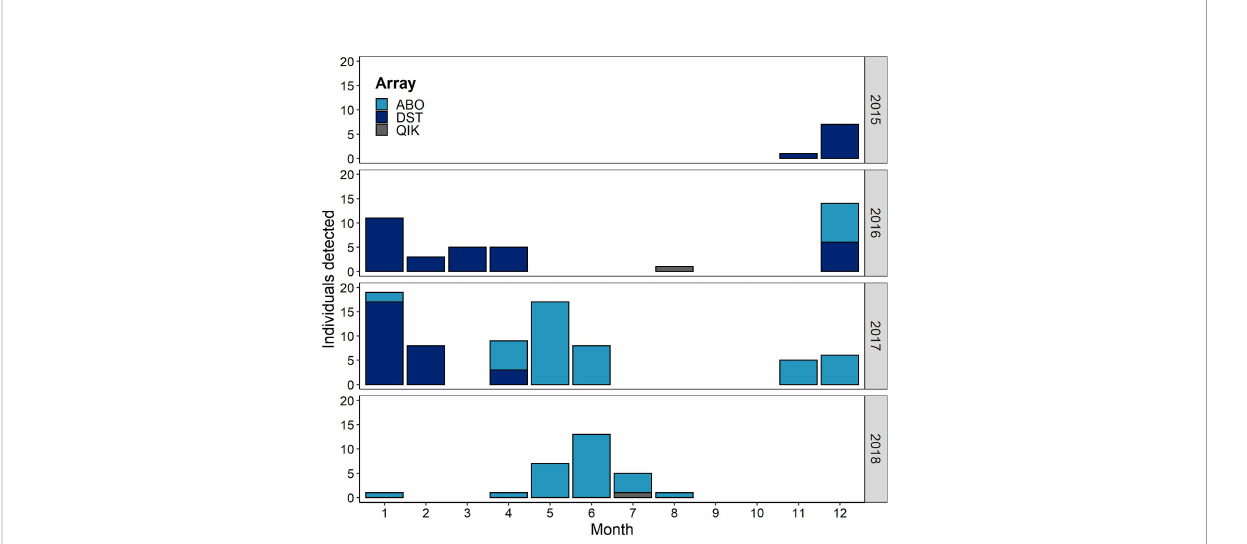
FIGURE 4 Total number of tagged Greenland sharks detected by acoustic receiver stations in offshore Baf fi n Bay (ABO, DST, and QIK arrays) listed by month and year and coloured by array ID. It should be noted that initial array deployment dates limit the number of detections observed before September 2016 (ABO array fi rst deployed 2016-08-31, DST deployed 2015-09-09, and QIK deployed 2015-10-07). [Colour